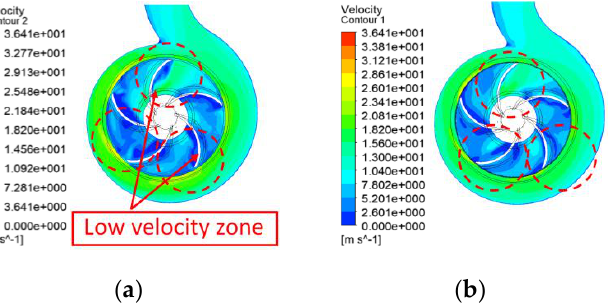
Figure 15. Pressure contours of flow region at 1500 rpm. ( a ) Original model; ( b ) rounded model.